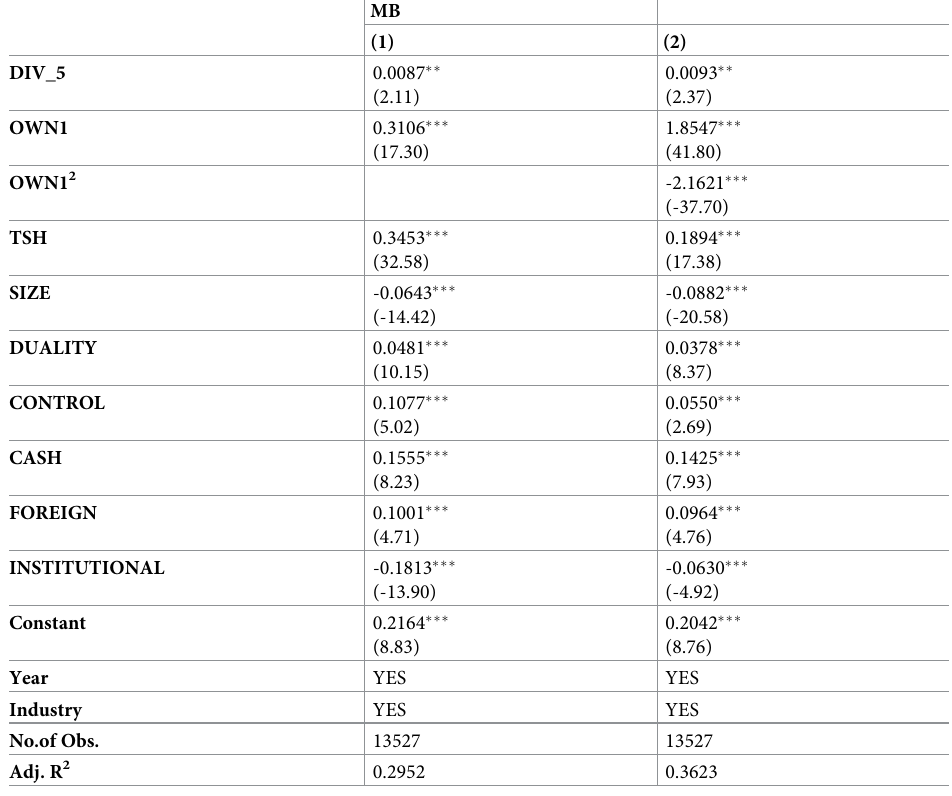
Table 3. The relation between continuous cash dividends, ownership concentration and firm